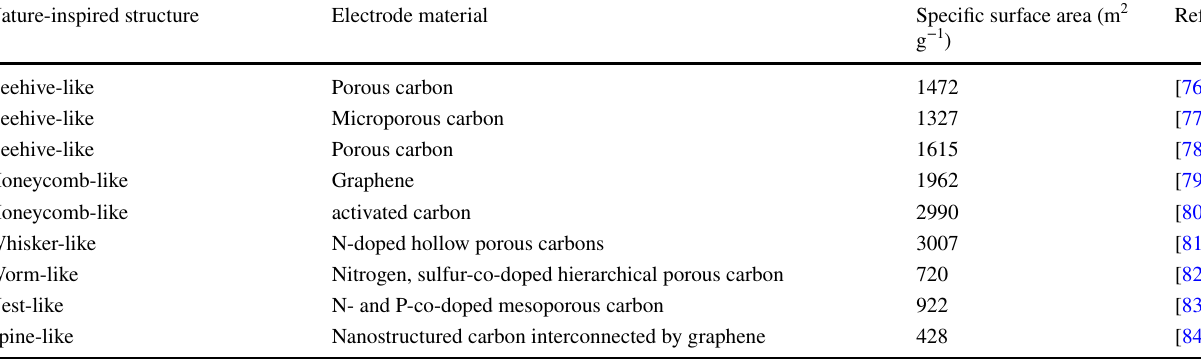
Table 1 Specific surface area of carbon with various animal- and human-inspired structures Nature-inspired